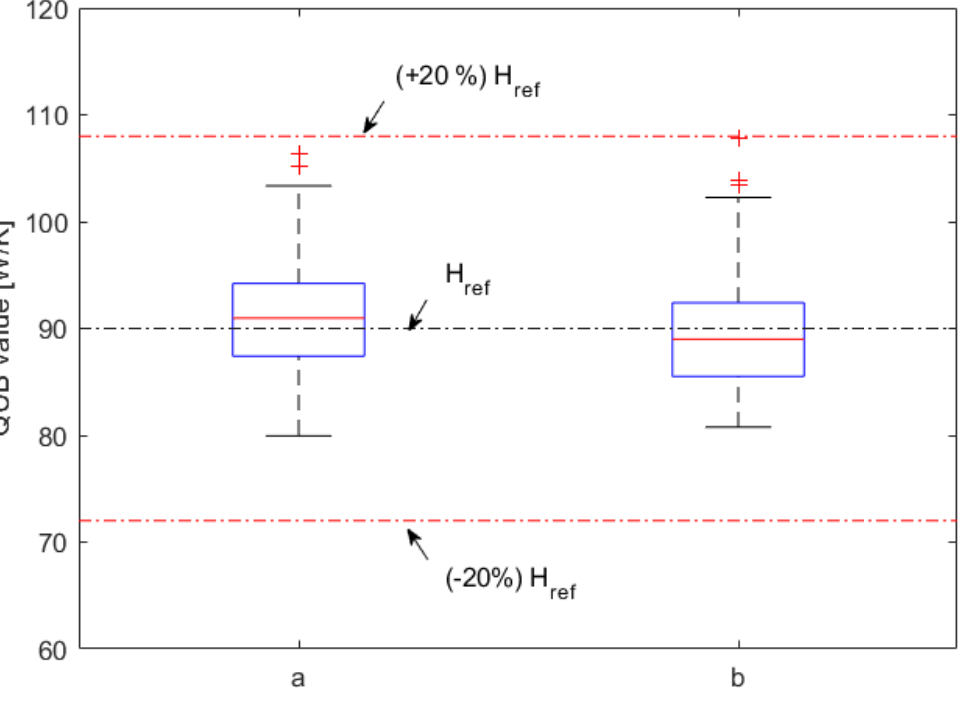
Figure 5. Comparison between QUB results at: ( a ) varying outdoor temperature; ( b ) constant outdoor temperature. The black dashed line shows the steady-state overall heat transfer coe ffi cient and the two red dashed lines show ± 20% of the steady-state overall heat transfer coefficient.